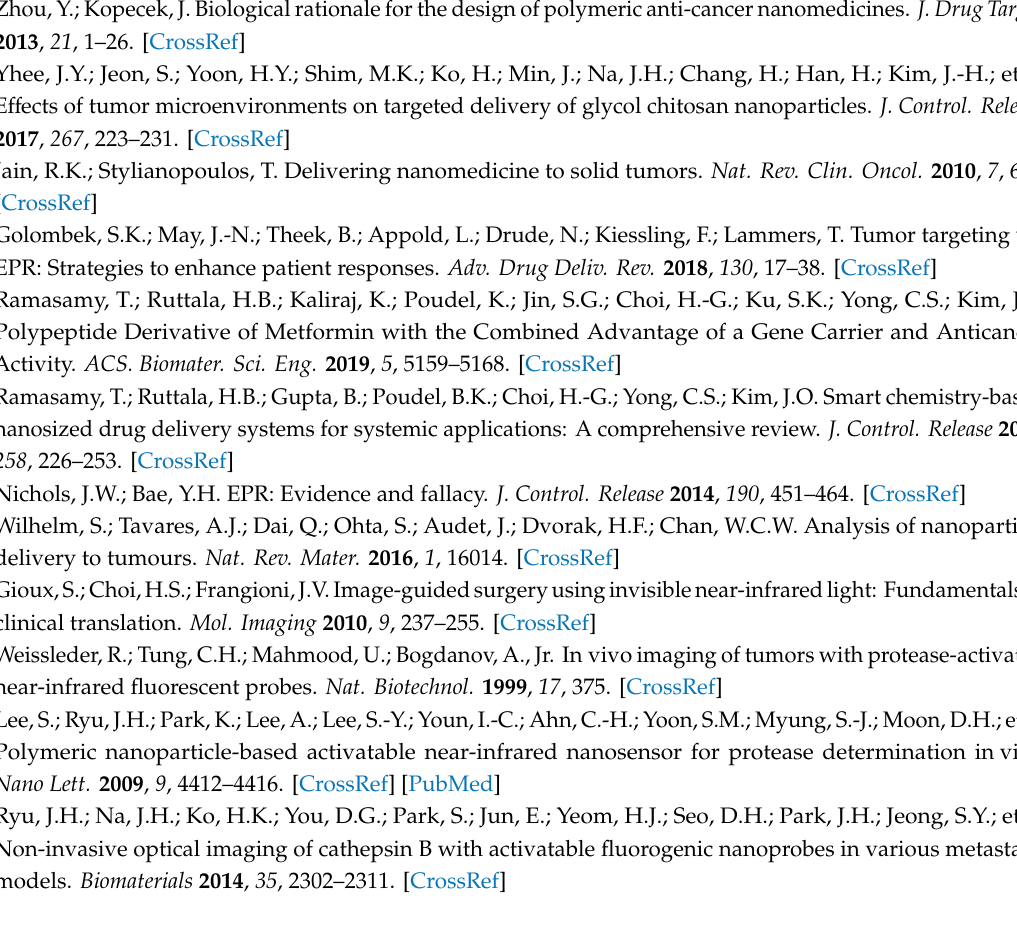
Figure S1: 600 MHz 1 H-NMR spectra; Figure S2: Morphologies of isolated VX2 tumor cells; Figure S3: Biodistribution of ICG-CNPs in VX2 tumor-bearing mouse; Figure S4: Representative images of image-guided surgery of VX2 tumor; Video S1: Image-guided surgery of VX2